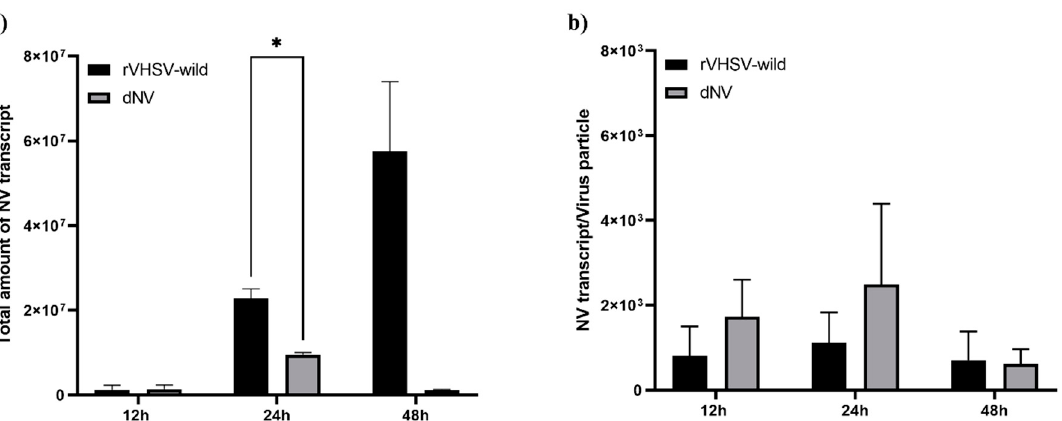
Figure 4. Quantification of the total number of NV transcripts ( a ) and NV gene expression levels per virus particle ( b ) in EPC cells using real-time RT–PCR. We inoculated EPC cells with rVHSV-wild or rVHSV-dNV (dNV) at MOI 0.1 and quantified the number of NV transcripts at 12-, 24-, and 48-h post-infection (n = 3, means ± SD, * p < 0.05).